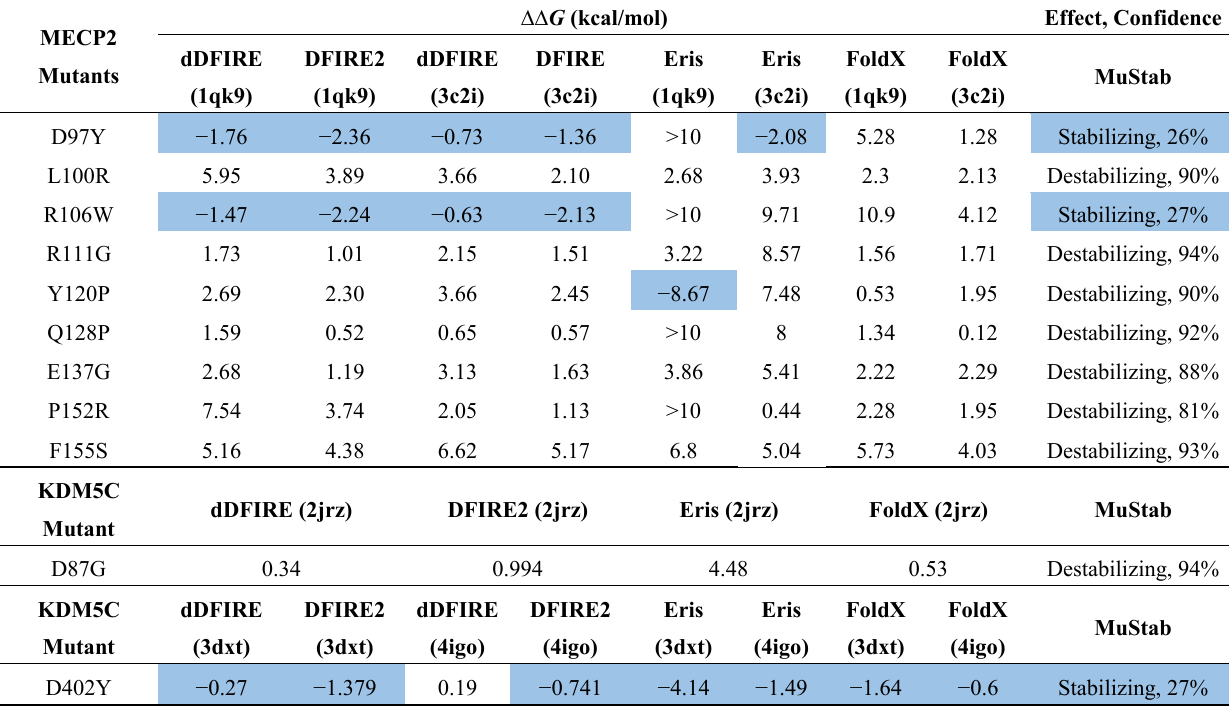
Table 4. Stability changes upon mutations. Stabilizing mutations are highlighted in blue, and the rest are identified as